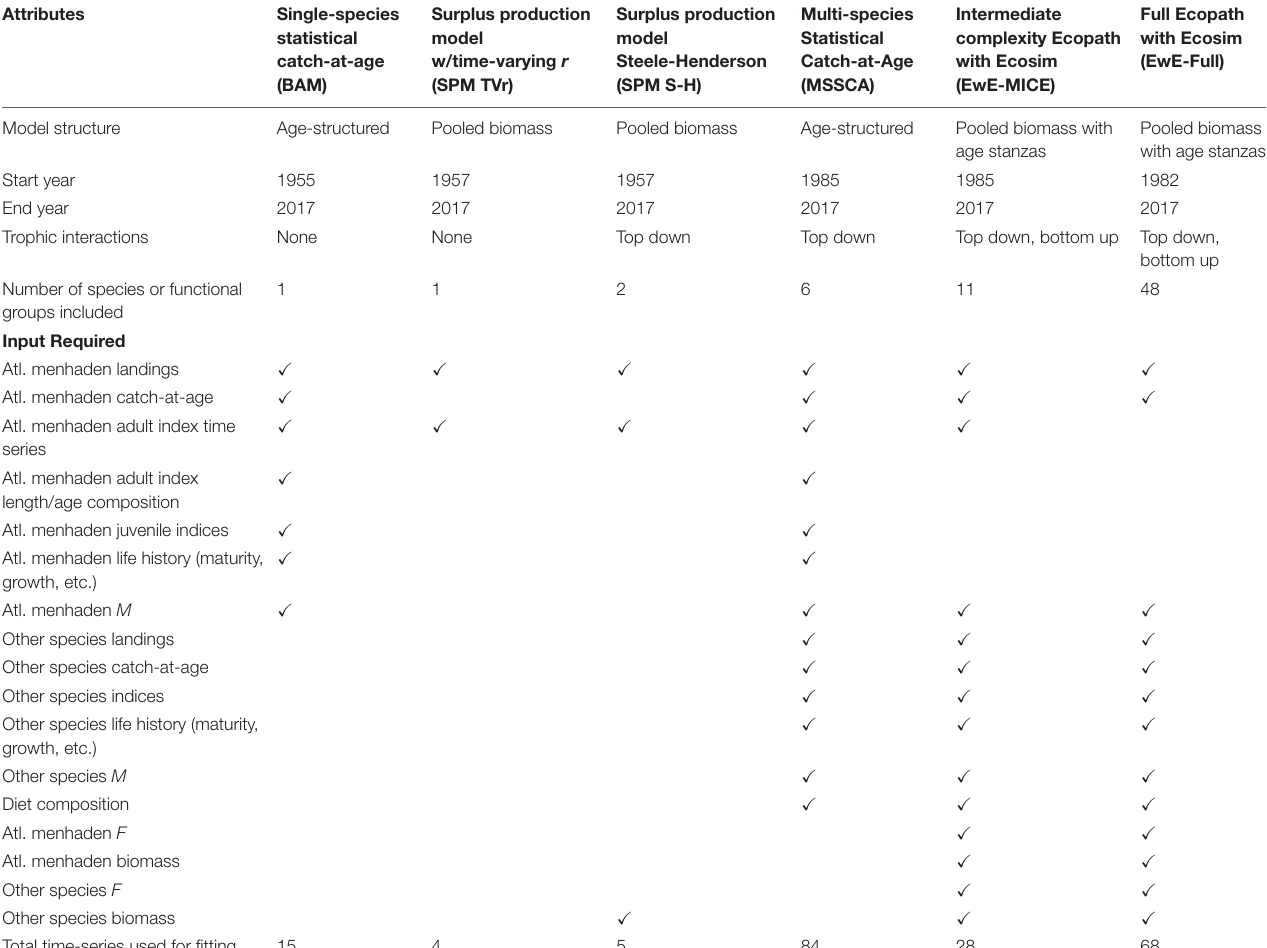
TABLE 1 | Comparison of model structure, attributes, and inputs used for ERP